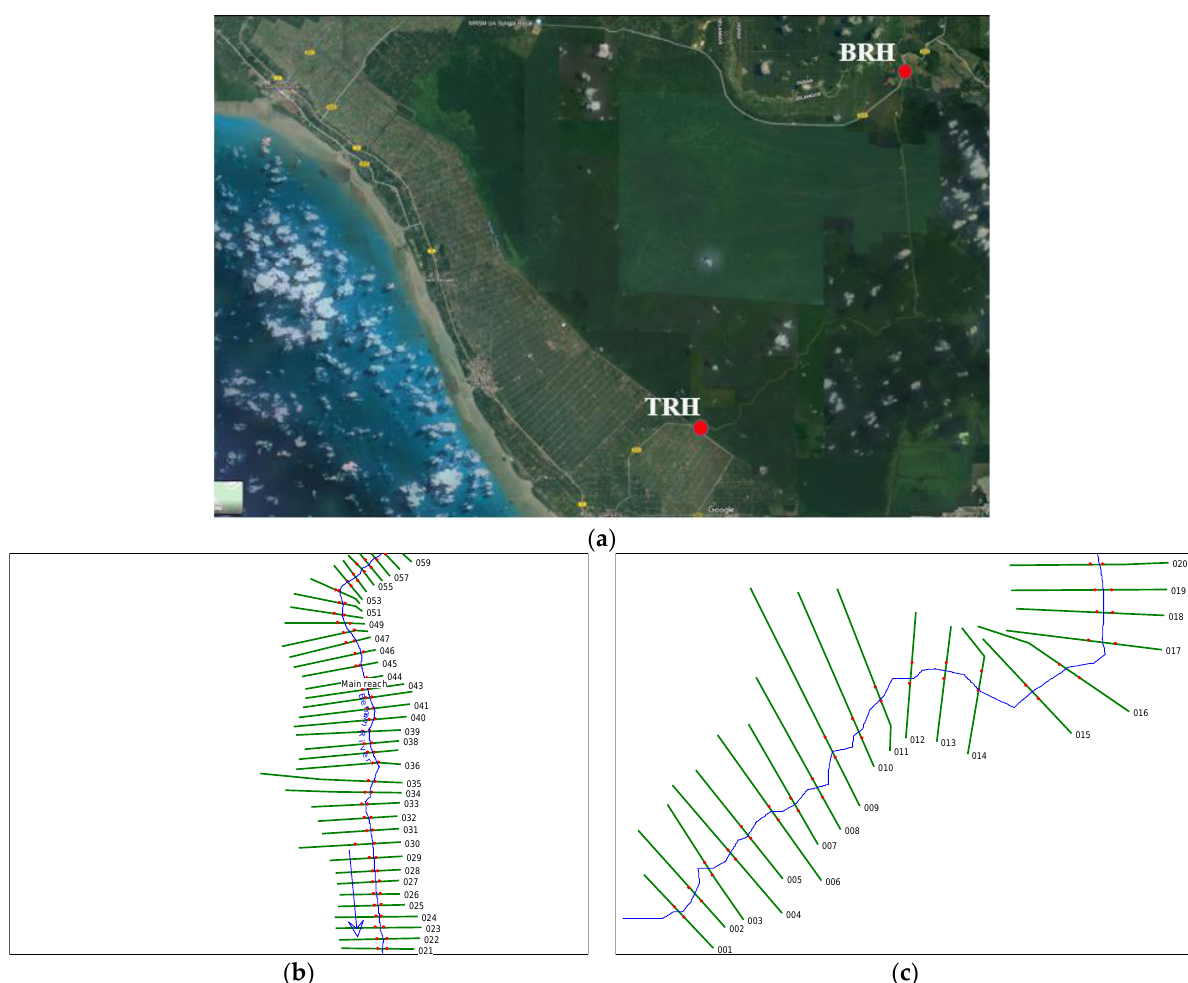
Figure 8. River geometry traits at the study location: ( a ) view of conveyance system from Bernam River Headworks (BRH) to Tengi River Headworks (TRH) (Map Data © Google Map, 2019); ( b ) cross-sections at Bernam River / Feeder canal; and ( c ) cross-sections at Tengi